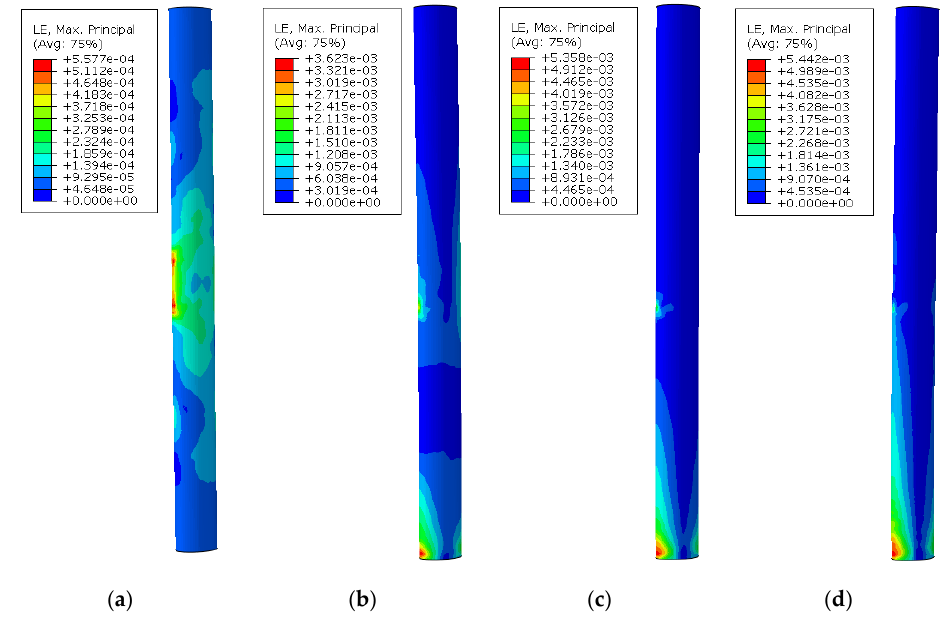
Figure 14. Strains on the steel tube. ( a ) Local response, 0.1 ms; ( b ) Overall response, 1.3 ms; ( c ) Stable response, 5.3 ms; ( d ) Descending response, 7.1 ms.